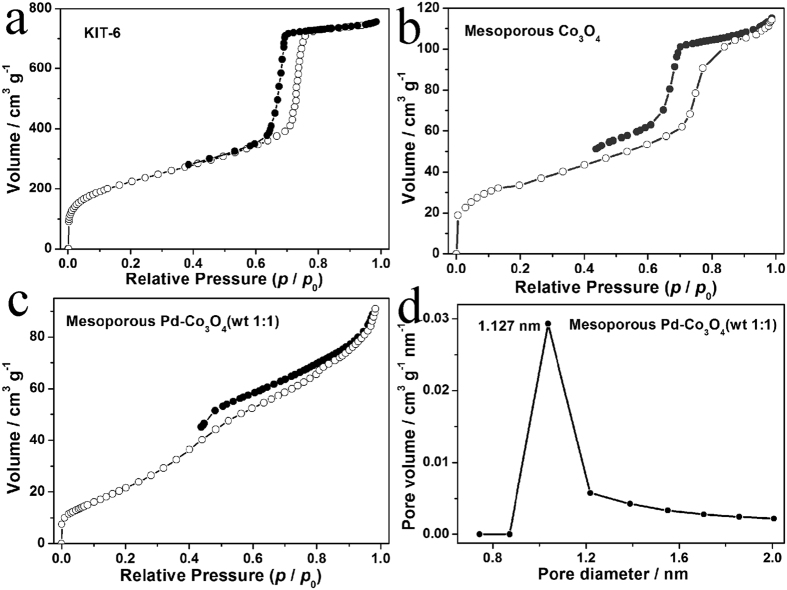
Nitrogen adsorption and desorption isotherms of (a) KIT-6, (b) mesoporous Co3O4, (c) Pd-Co3O4(wt 1:1); (d) pore size distribution of Pd-Co3O4(wt 1:1).